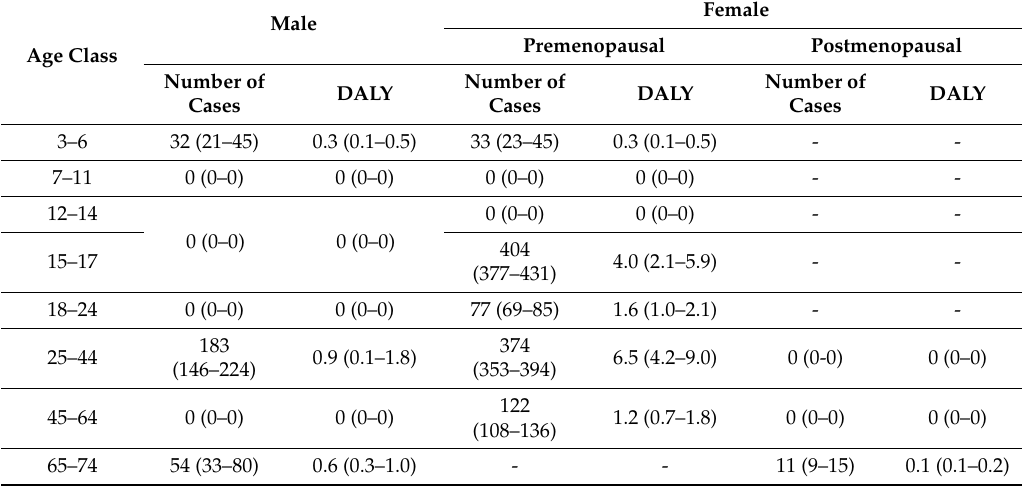
Table 4. Number of cases and disability adjusted life years (DALY) per 100,000 individuals of iron deficiencies anemias in France, per age class and gender. Mean value and its 95% confidence